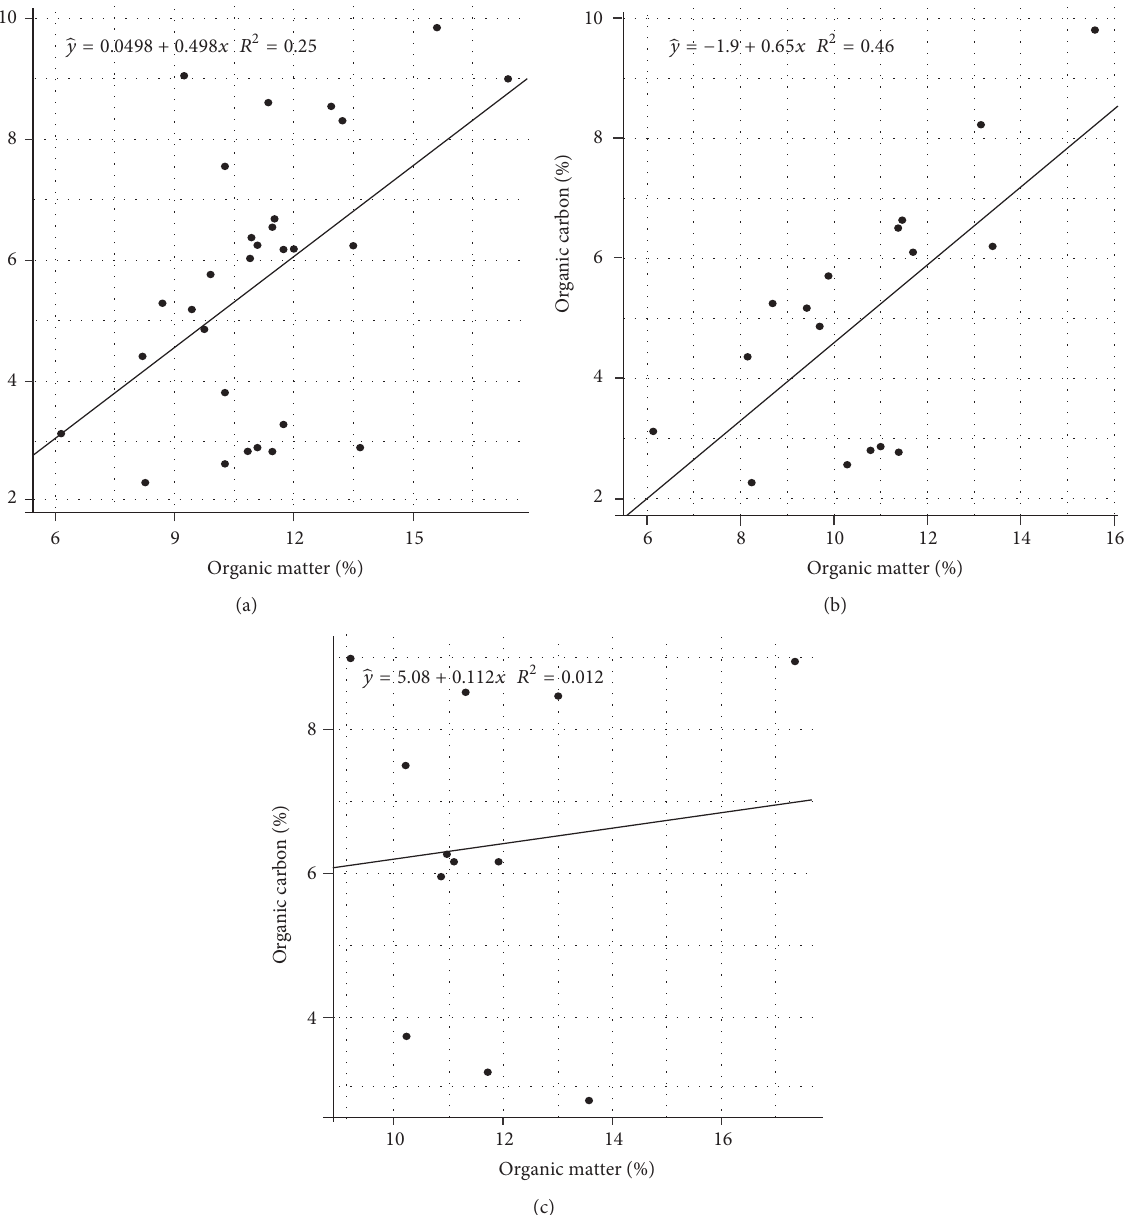
Figure 3: Linear regression of soil organic matter (OM) measured by loss on ignition (LOI) to soil organic carbon (SOC) measured by gas combustion analysis for (a) all soil samples ( 𝑛 = 29 ), (b) soil samples near the ocean ( 𝑛 = 17 ), and (c) soil samples near the land ( 𝑛 = 12 ). The delineation of soil sample groups for (b) and (c) was divided from the center area parallel to the shoreline along the study area.